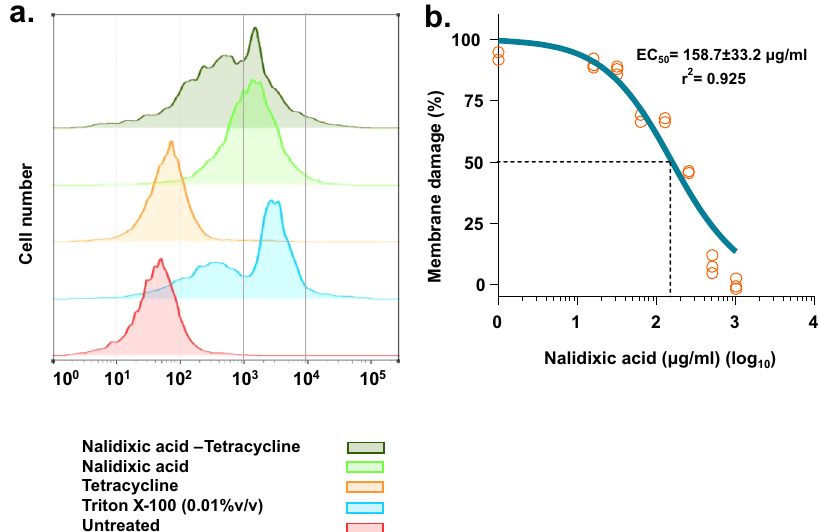
Fig. 3 Role of nalidixic acid in membrane damage. a Flow cytometry analysis (Half Offset graphs) showing the role of nalidixic acid in membrane damage. Membrane damage was assessed using membrane-impermeable dye SYTOX TM Orange. Nalidixic acid treatment causes a signi fi cant shift (55% population showed shift) in fl uorescence. Tetracycline does not cause membrane damage. The combination displays a similar shift to nalidixic acid-treated cells. Triton X-100 (0.01% v/v) acts as a positive control. Ten thousand total events were captured and are shown here. b Dose – response curve showing membrane damage caused by nalidixic acid. Membrane damage was assessed using SYTOX TM Orange. Cells were incubated with increasing concentration of nalidixic acid and fl uorescence was monitored over 1 h. Cells with no nalidixic acid acts as control (0% membrane damage). Effective concentration (EC 50 ) for membrane damage was plotted using “ dose response – inhibition, log [inhibitor] vs. normalized response parameter ” in GraphPad Prism 7